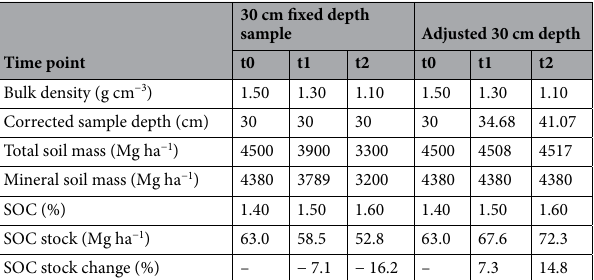
Table 3. Scenario 1: Changes in SOC stocks, total soil mass, and mineral soil mass mass using the fixed depth and adjusted depth (ESM correction) approach at three time points (t0, t1, and t2).